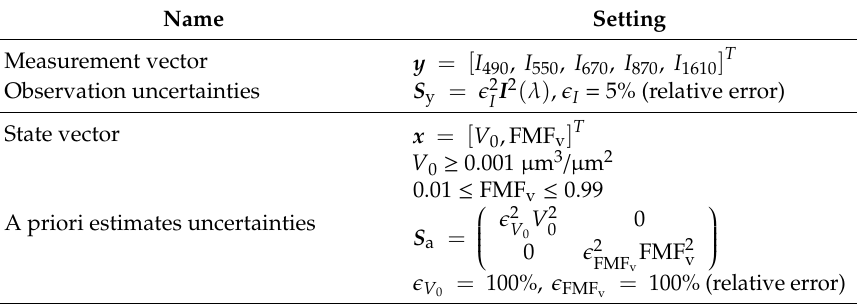
Table 3. Definition of the measurement vector and state